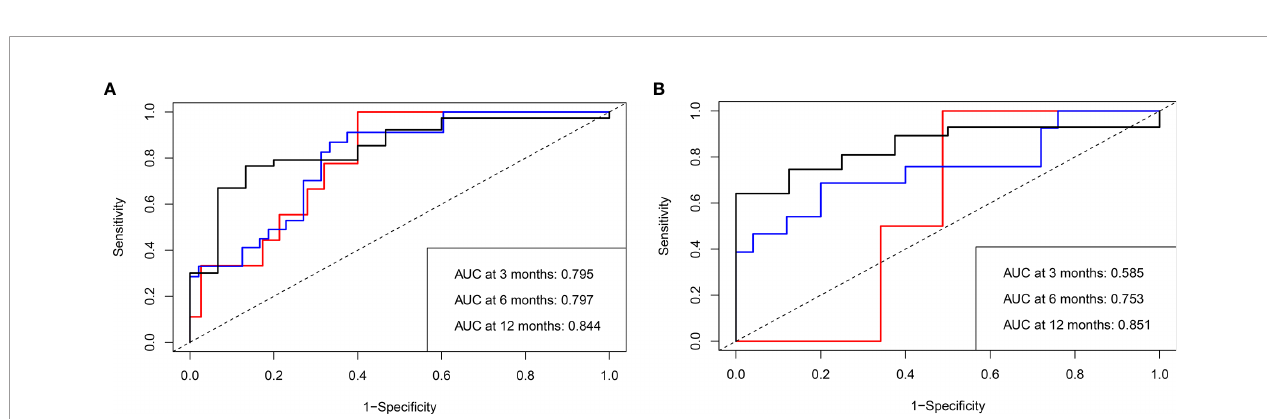
FIGURE 4 | Receiver operating characteristic (ROC) curves of the nomogram to predict progression-free survival (PFS) in both the training and validation cohorts. The area under the curve (AUC) of the probability of PFS at 3, 6, and 12 months in (A) the training and (B) validation cohorts, respectively.